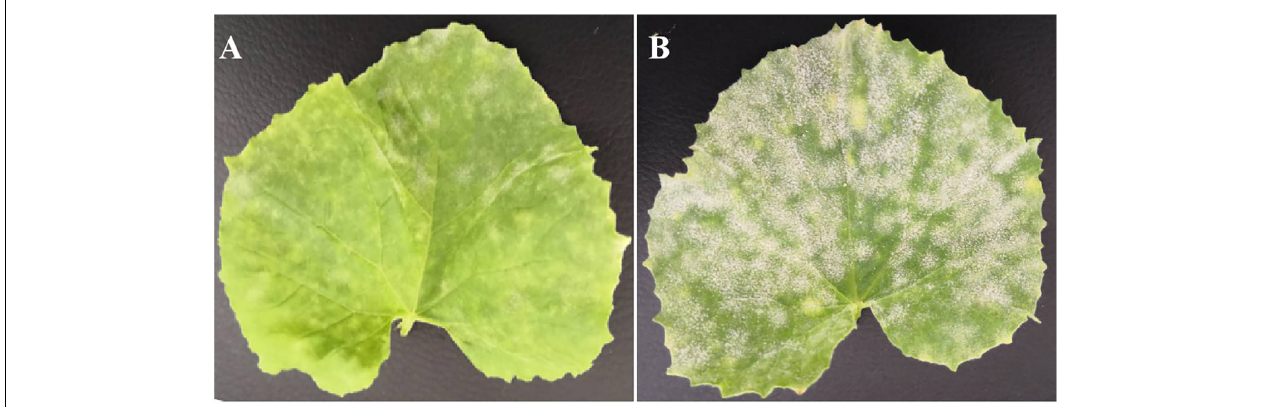
FIGURE 1 | Phenotype of resistant parent wm-6 and susceptible parent 12D-1, 12 days after inoculation with P . xanthii . (A) The phenotype of the resistant parent wm-6, 12 days after inoculation with P . xanthii . (B) The phenotype of the resistant parent 12D-1, 12 days after inoculation with P . xanthii . The experiments were repeated at least three times independently, with similar